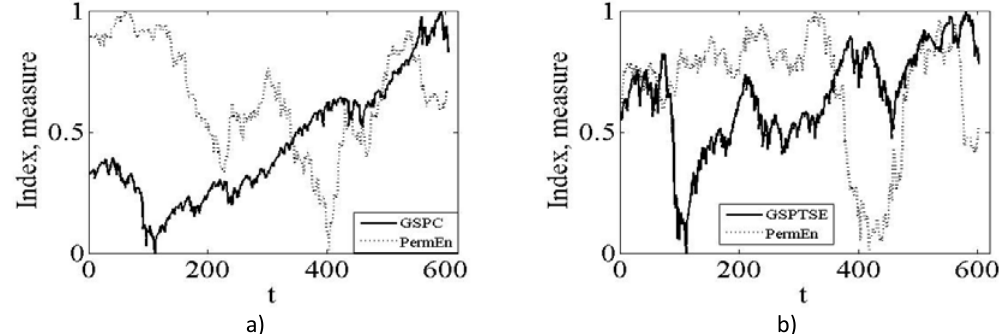
Fig. 5: Comparative dynamics of output series and permutation entropy for stock markets: (a) the United States, (b) Canada